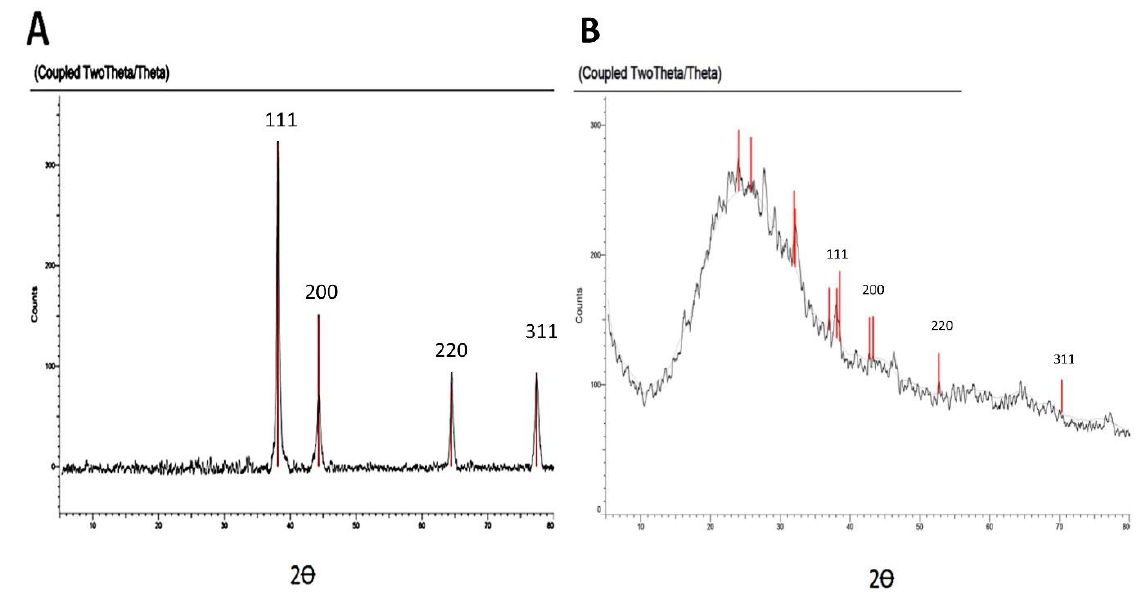
Figure 5. X-ray diffraction pattern of the biosynthesized AgNPs using ( A ): A. glabra and ( B ): A. squa- mosa .